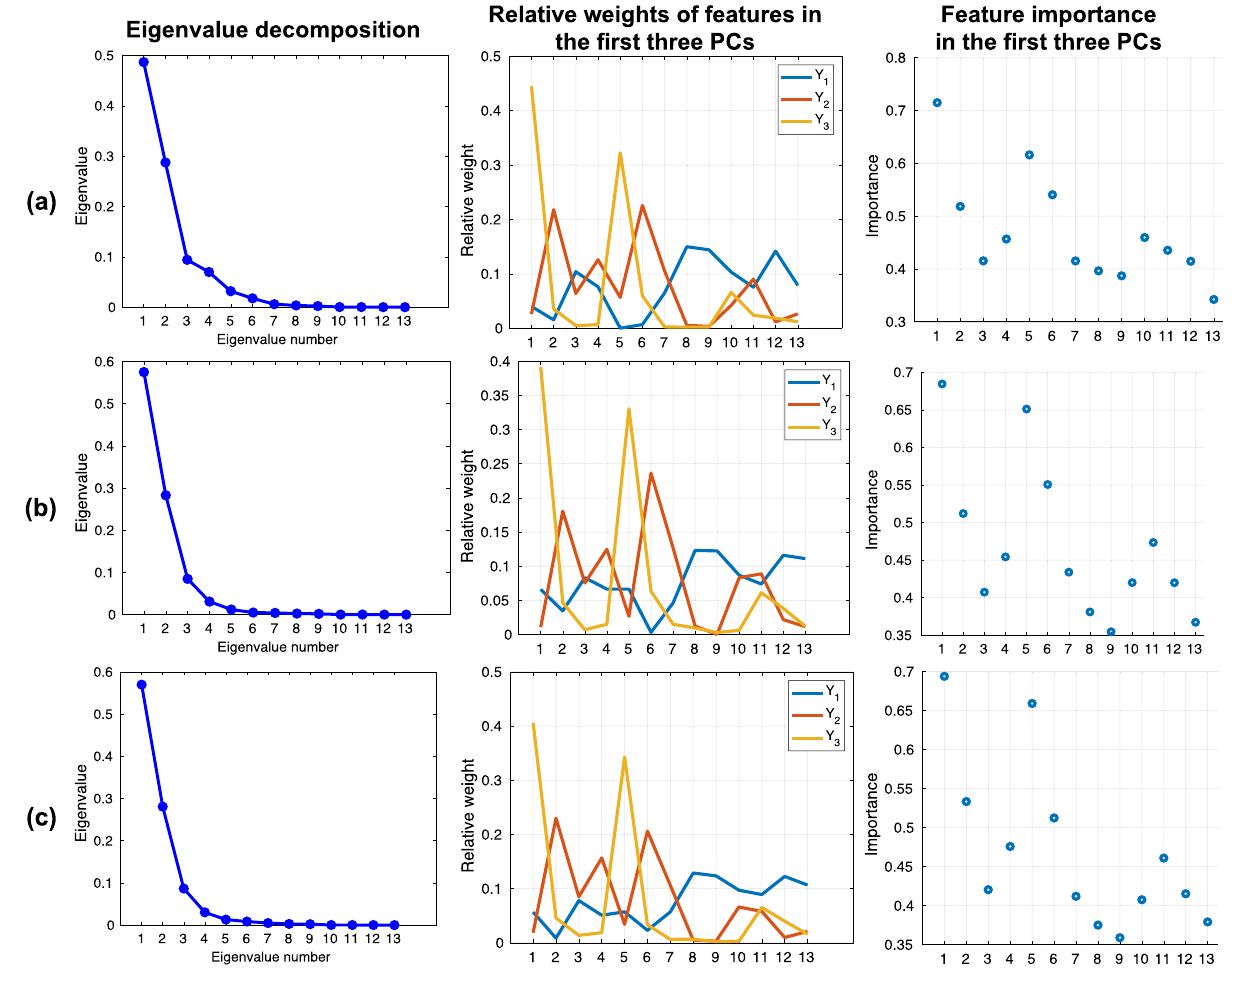
Figure 6. PCA-based analysis of the importance of radiomic features for all image types: ( a ) Original; ( b ) Cubic; ( c ) GAN-SR. The first column shows the line plots of the values of the eigenvalues as a function of the number of eigenvalues. This is useful for the evaluation of the PCs required. The second column shows the relative weights of the original features on the first of three PCs, while the third column depicts the relative importance of the features (according to the IDs defined in Table 1) in the first three